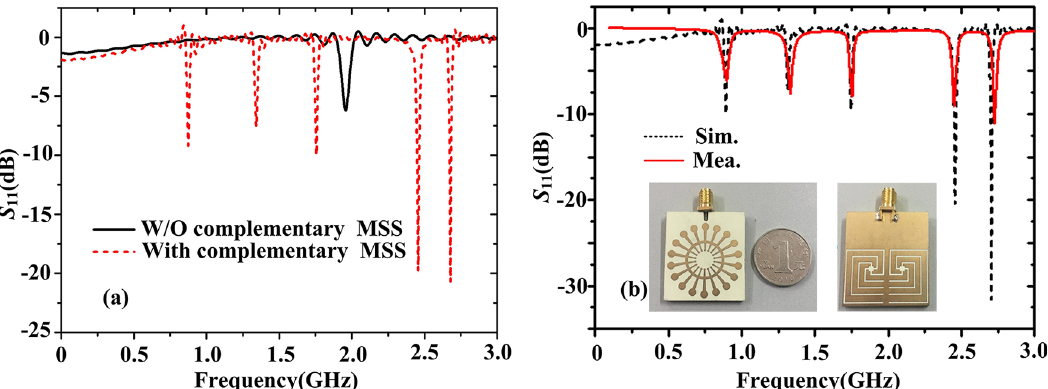
Fig. 5. (a) Simulated re fl ection coef fi cients of the antenna with and without the complementary MSS with unequal arm length. (b) Measured and simulated re fl ection coef fi cients of the fabricated antenna.